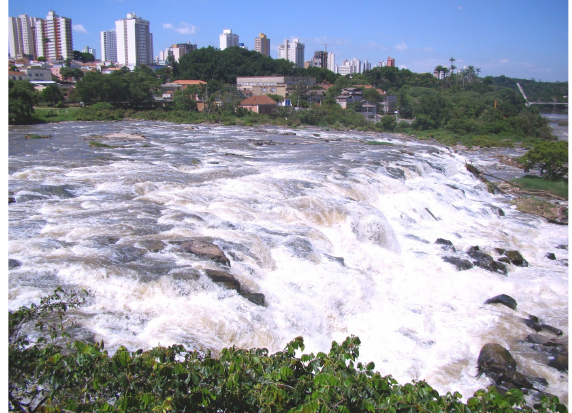
FIGURE 4 | Salto de Piracicaba, Piracicaba River, tributary of Tietê River, Upper Paraná River basin. The most probable type-locality spot of Hypostomus hermanni . Brazil, São Paulo State,